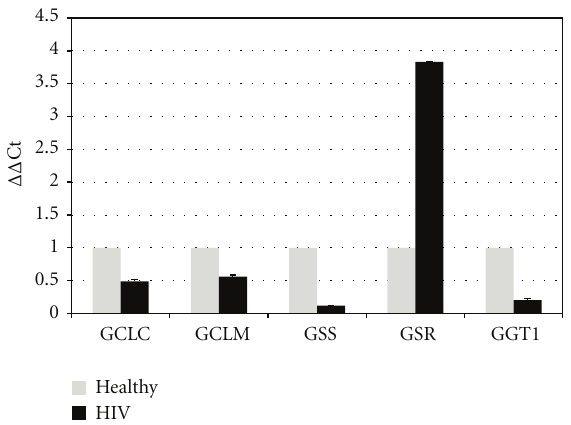
Figure 5: Relative gene expression for the specified target genes in comparison to the endogenous control ACTB. A comparison of gene expression in macrophages from healthy and HIV-infect- ed subjects demonstrates reduced gene expression for all genes involved in the de novo synthesis of GSH in macrophages from HIV-infected subjects. A greater than 3-fold increase in GSR ex- pression is observed in HIV-infected macrophages. Results are from n = 3 individuals for both healthy and HIV-infected